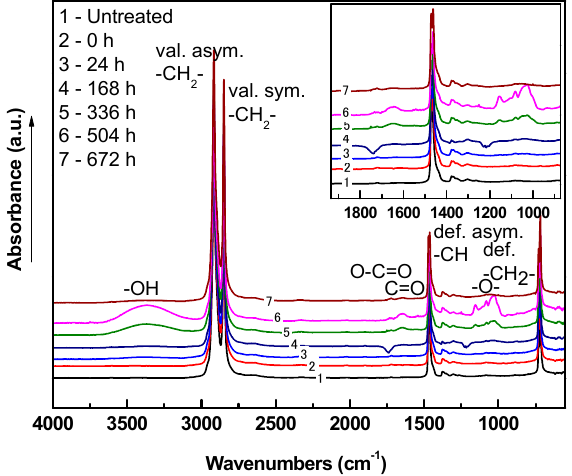
Figure 17. FTIR spectra of LDPE plasma treated for 120 s using nitrogen and stored in water.